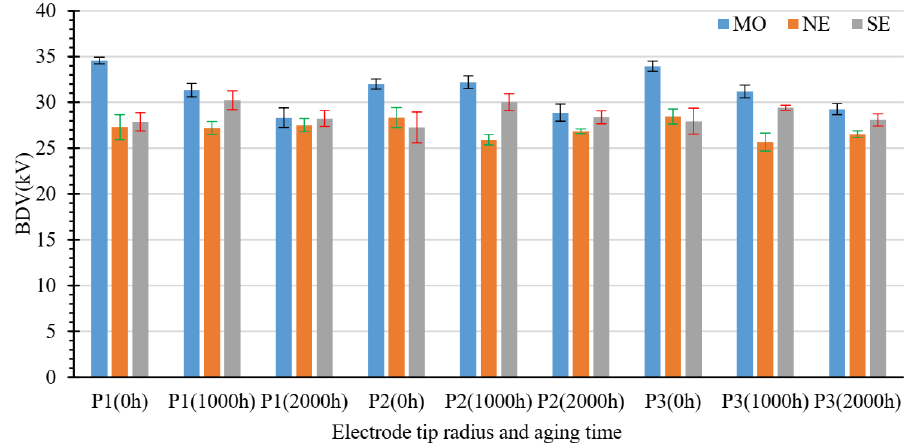
Figure 6. Breakdown voltage as a function of electrode tip and aging